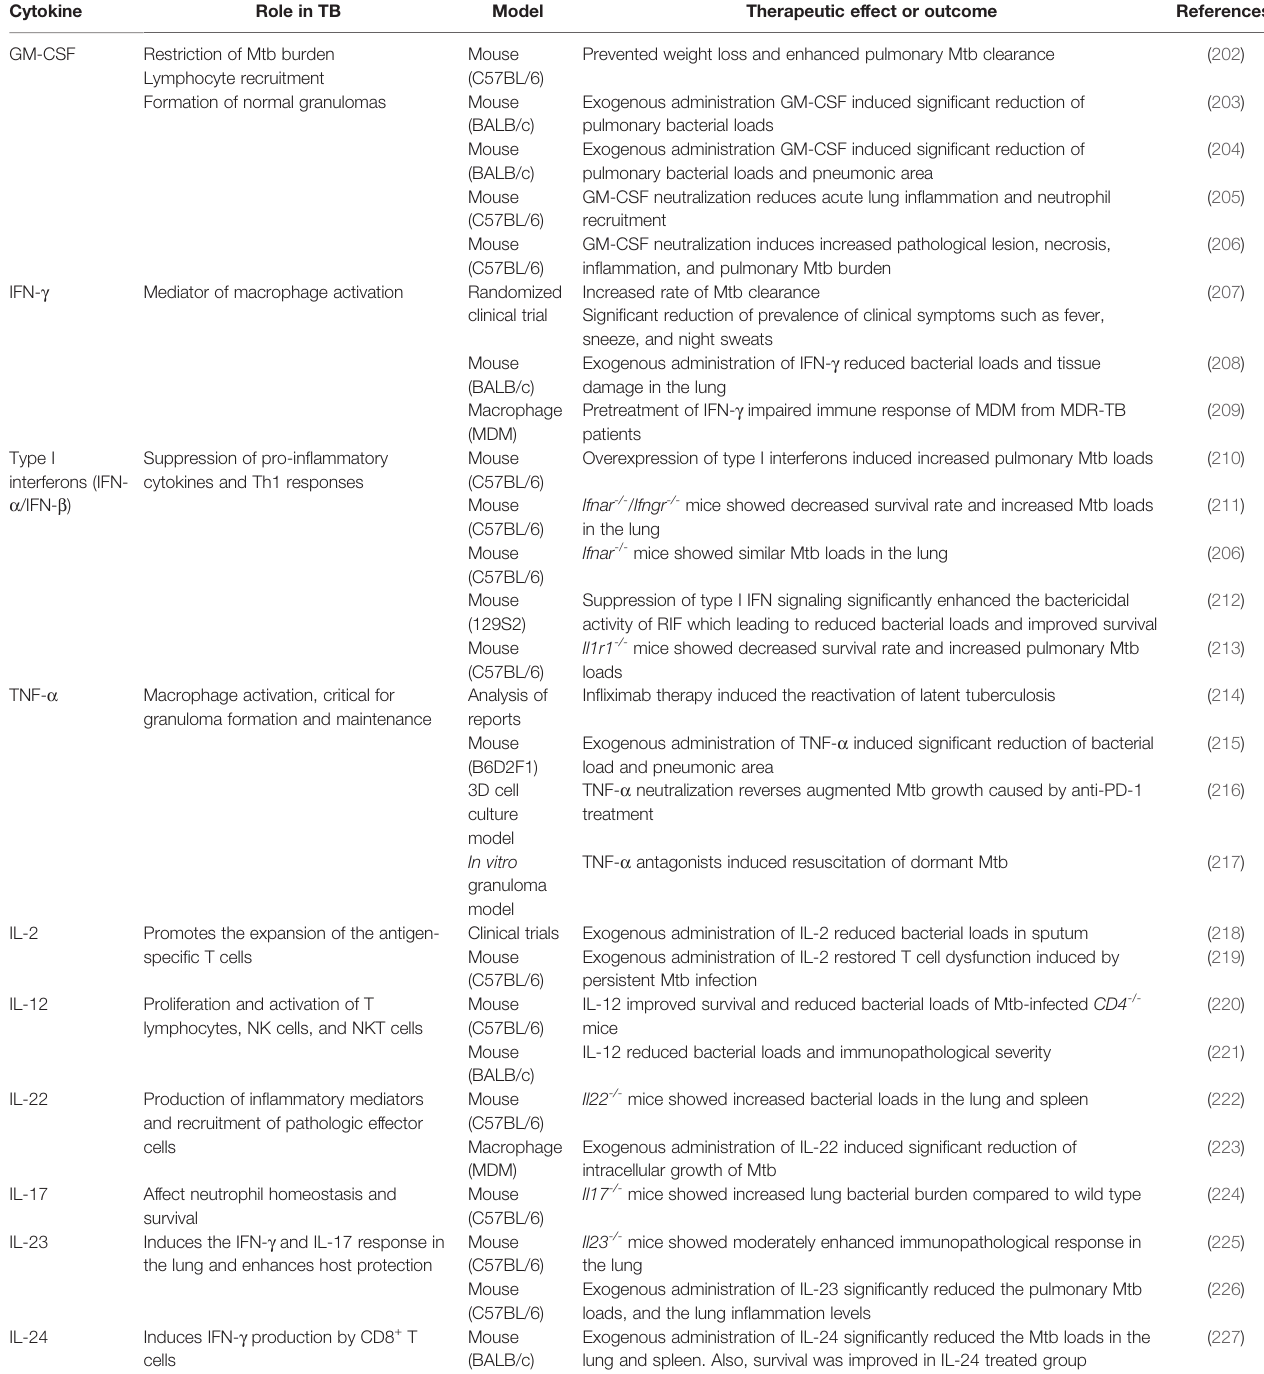
TABLE 2 | Effect of cytokines on host immunity in